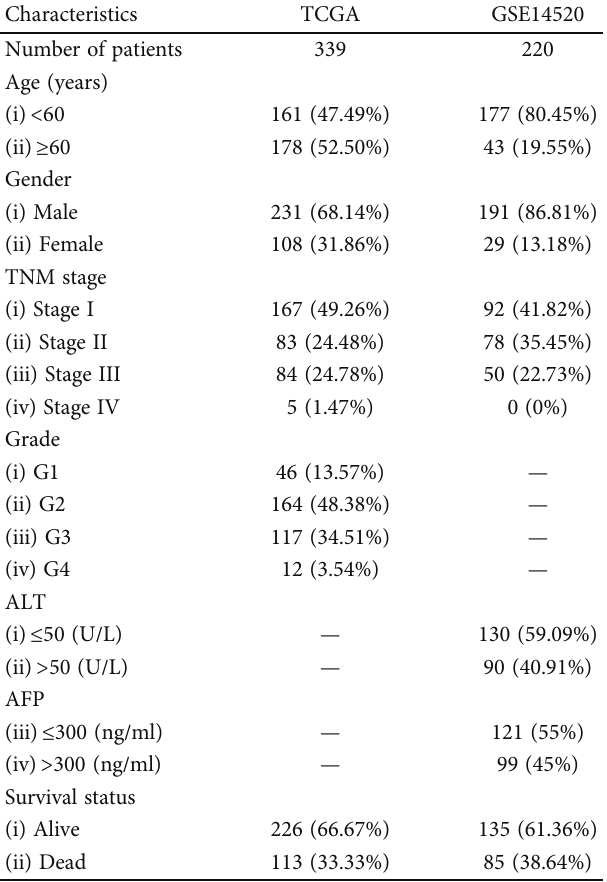
Table 1: Clinical information of HCC patients enrolled in this